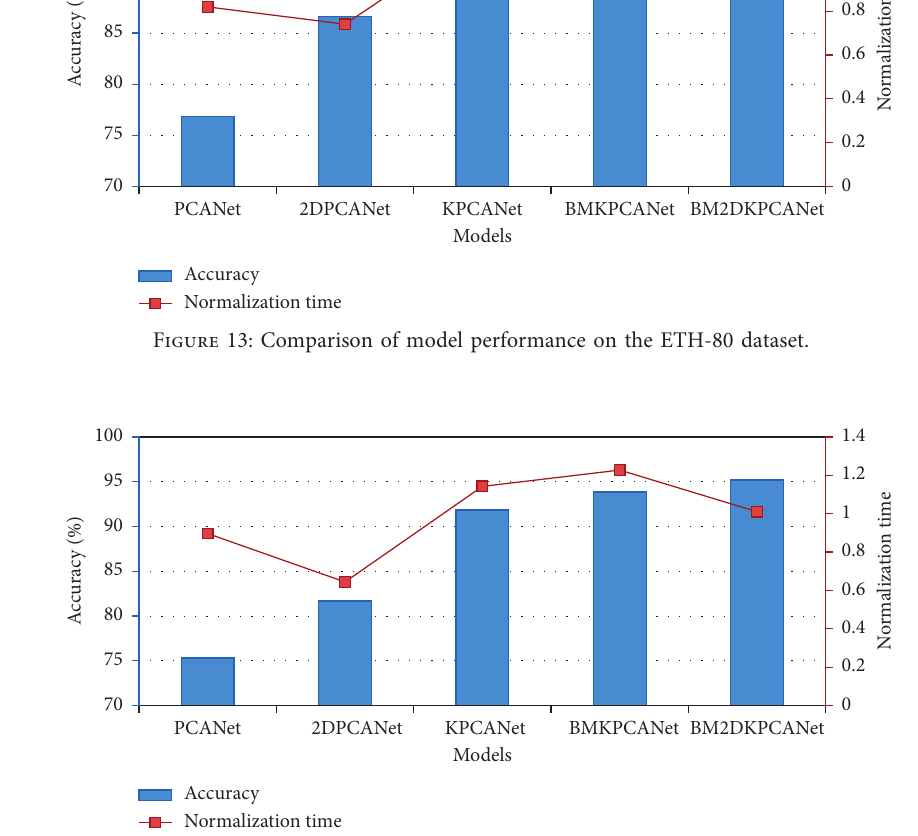
Figure 14: Comparison of model performance on the COIL-100 dataset.